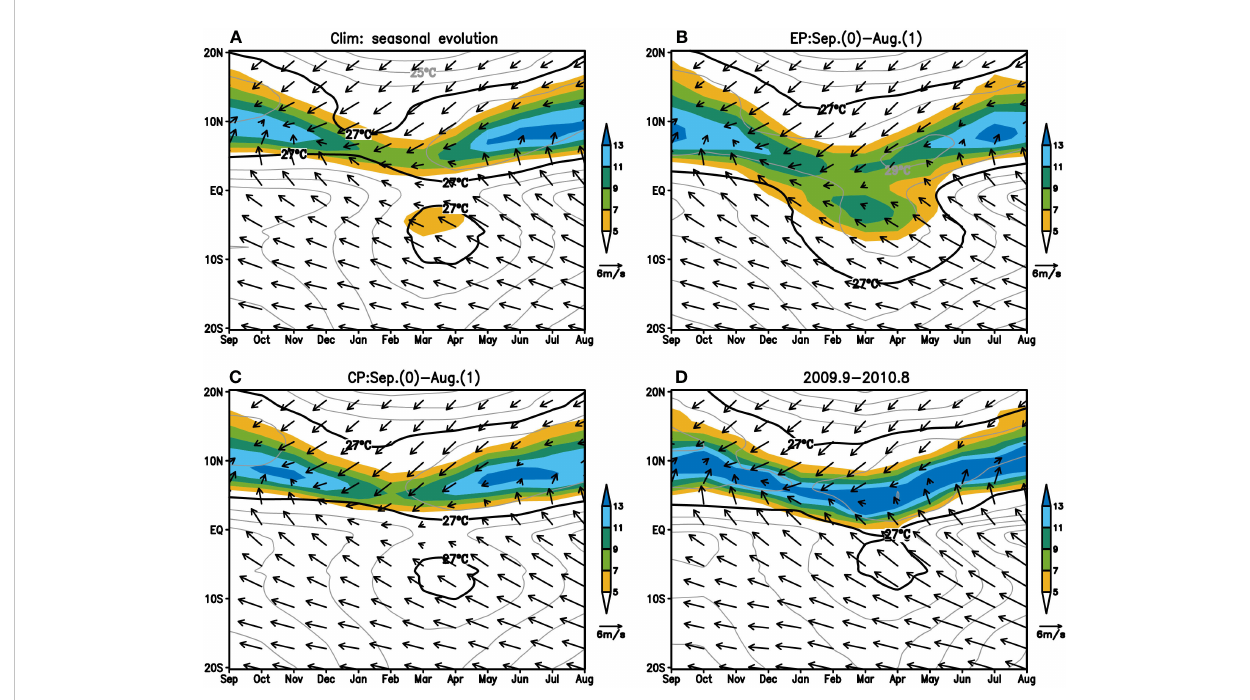
FIGURE 2 Seasonal evolution of zonal-mean rainfall (color shaded; units: mm/day), SST (contours; units: °C), and surface winds (vectors; units: m/s) over the eastern Paci fi c Ocean (140°W – 80°W) for (A) the Climatology; (B) the composite of EP-type events; (C) the composite of CP-type events and (D) the 2009/2010 mixed-type event.